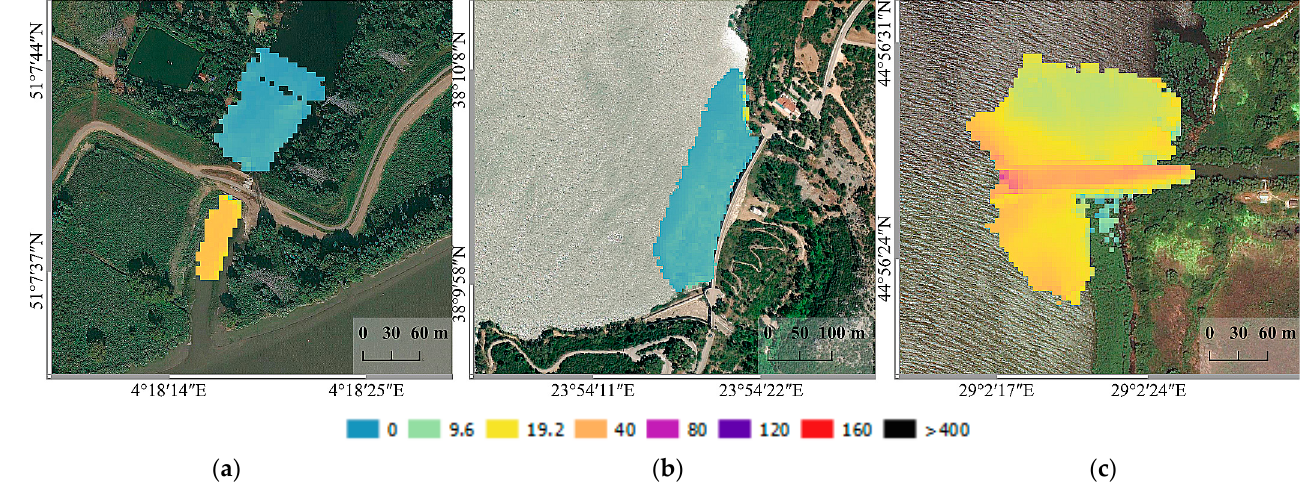
Figure 6. Examples of generated mosaicked turbidity maps. A logarithmic colour scaling is applied with units expressed in FNU. ( a ) Rupelmondse Creek; ( b ) Lake Marathon; ( c ) Danube Delta.